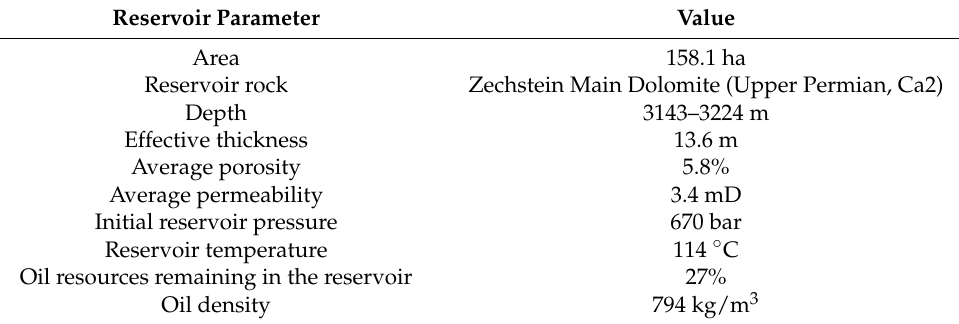
Table 1. Basic parameters of the